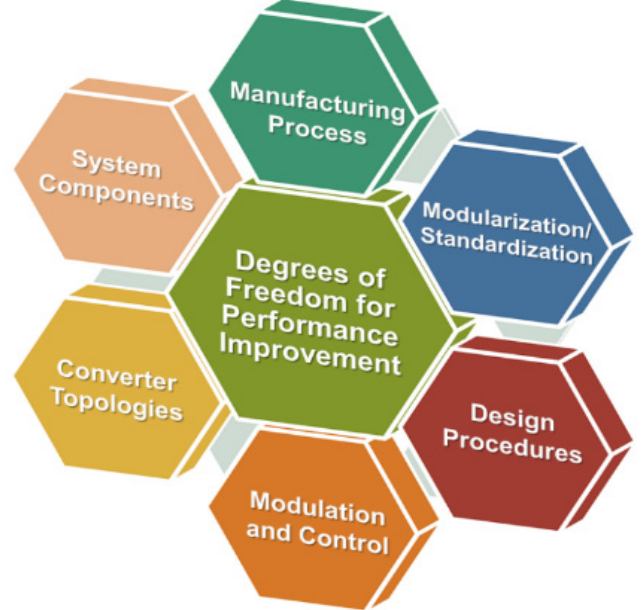
Figure 2. Degrees of freedom for performance improvement.